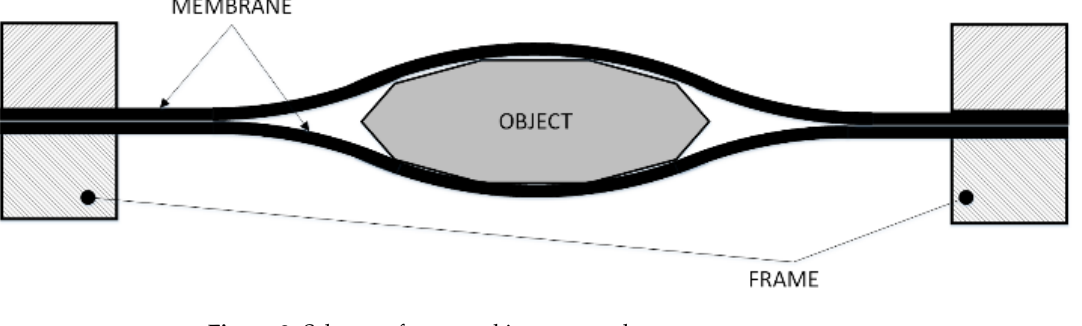
Figure 3. Scheme of new packing approach.